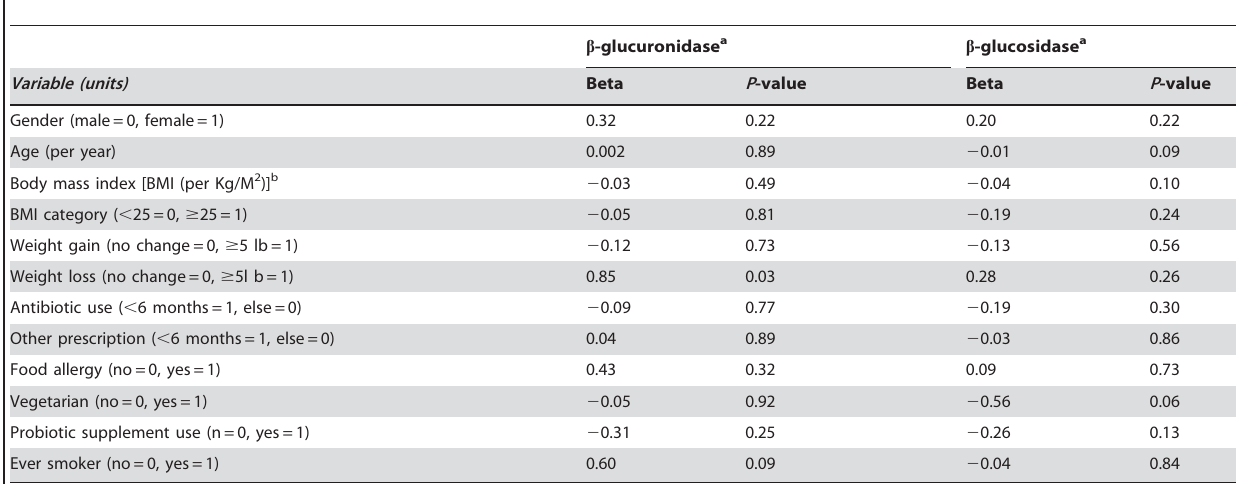
Table 1. Associations of b -glucuronidase and b -glucosidase mean activity levels with demographic and questionnaire data of 51 study